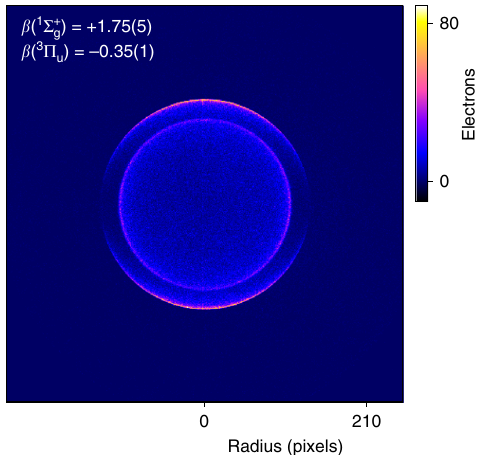
at 355 nm. Fast electrons are mapped to 2 state observed as an outer ring and g state represented by the inner ring. u electrons g electrons u